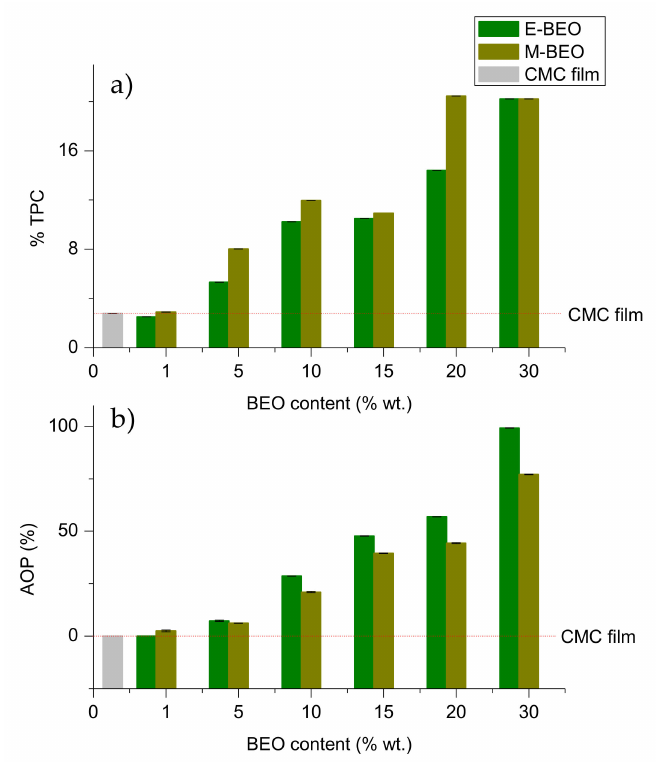
Figure 7. ( a ) Total phenolic content (TPC) and ( b ) antioxidant (AOP) of CMC films formulated with di ff erent concentrations of